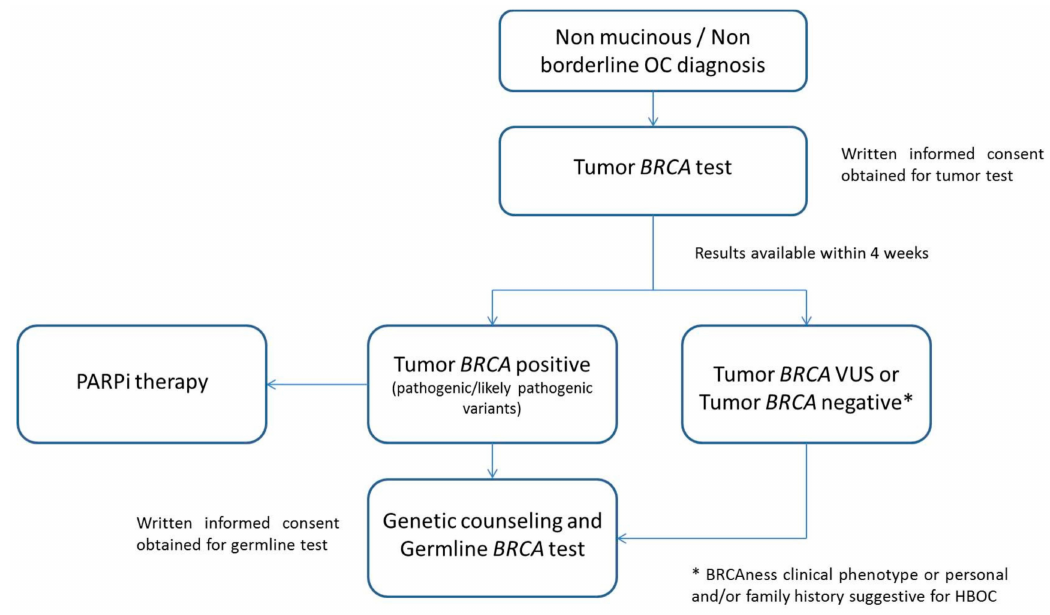
Figure 3. Tumor BRCA test workflow. OC: ovarian cancer; PARPi: poly (adenosine diphosphate (ADP)-ribose) polymerase inhibitors; HBOC: hereditary breast and ovarian